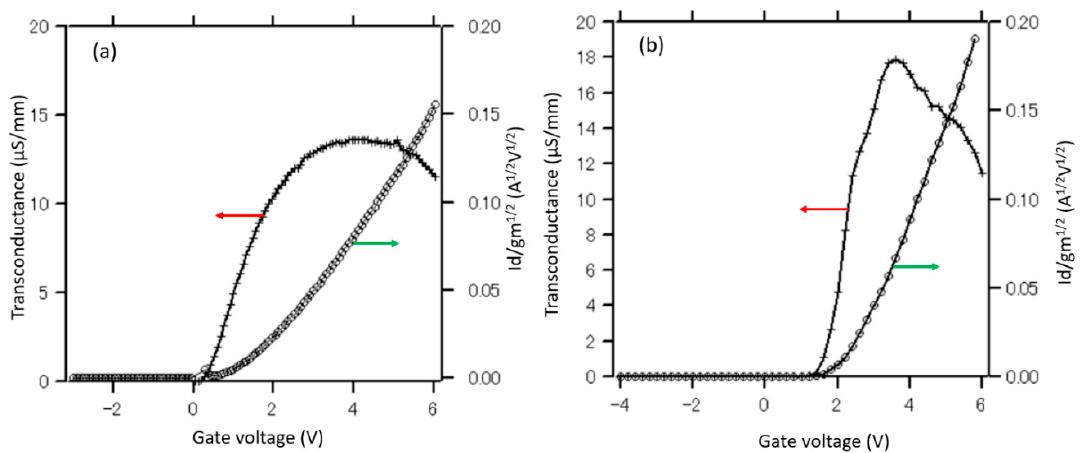
Figure 5. Y-function and transconductance of MOSFETs fabricated using the ion implantation technique ( a ) and regrowth method ( b ).